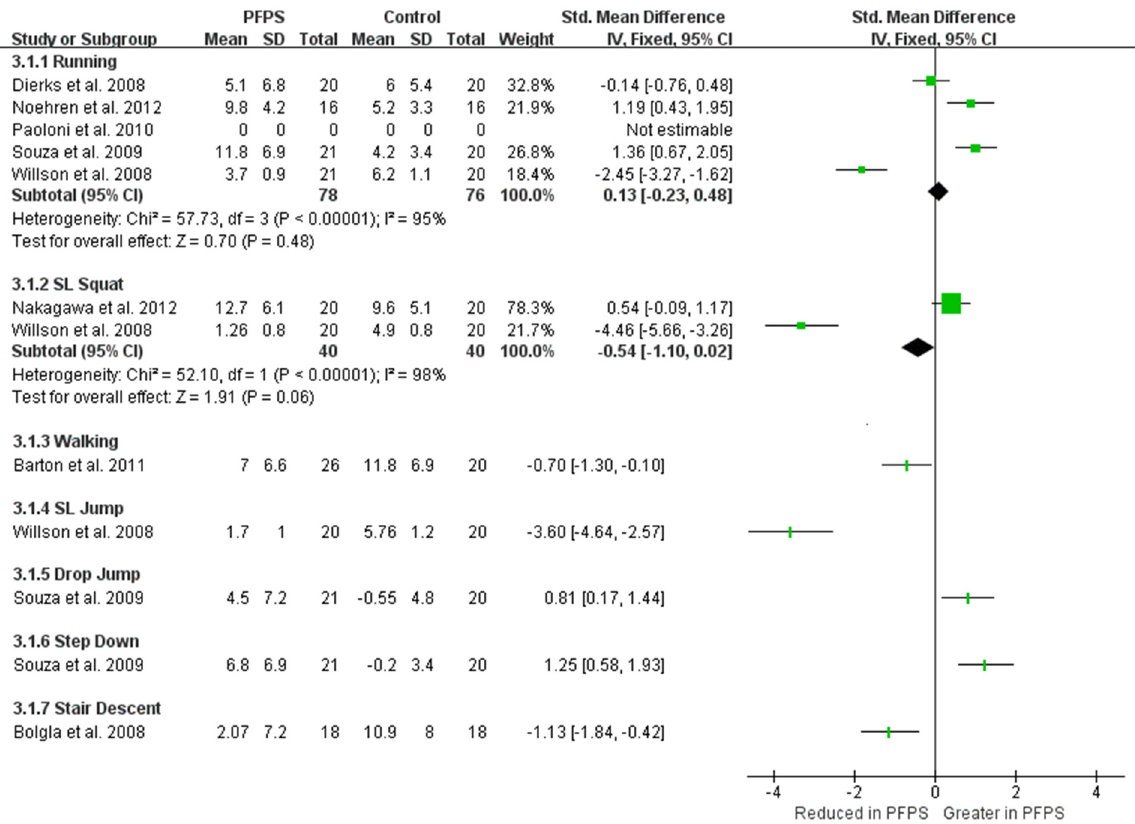
activities activities.